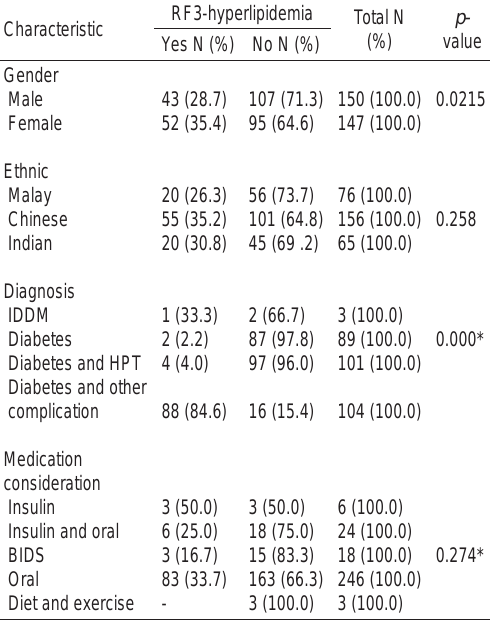
TABLE 5. Characteristic determination of RF3 - hyperlipid- emia in study population